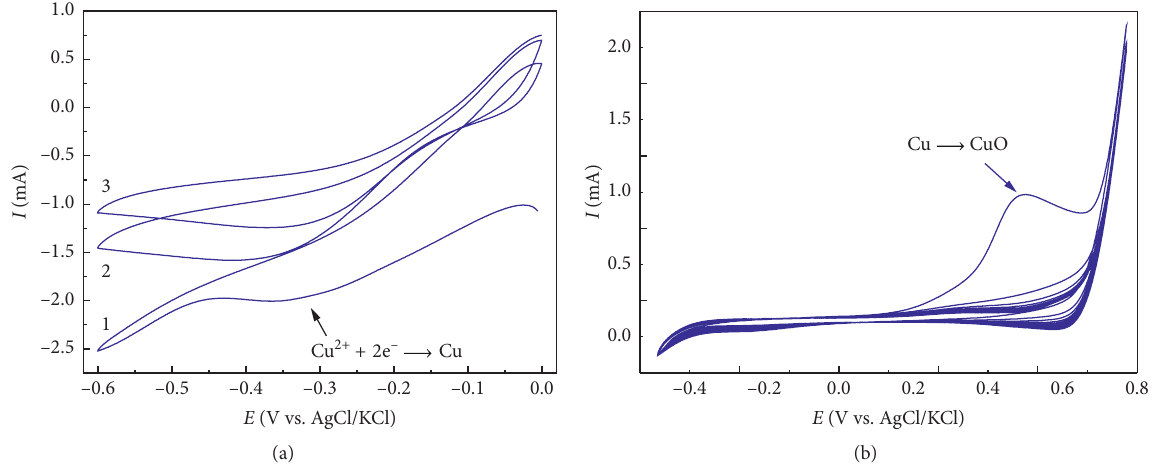
Figure 4: CVs recorded during electrodeposition of Cu onto the PANI/316L electrode from 0.01 M CuCl solution (a) and partially oxidize Cu into CuO in 0.1M NaOH electrolyte (b), with the scan rate of 100mVs − 1 .